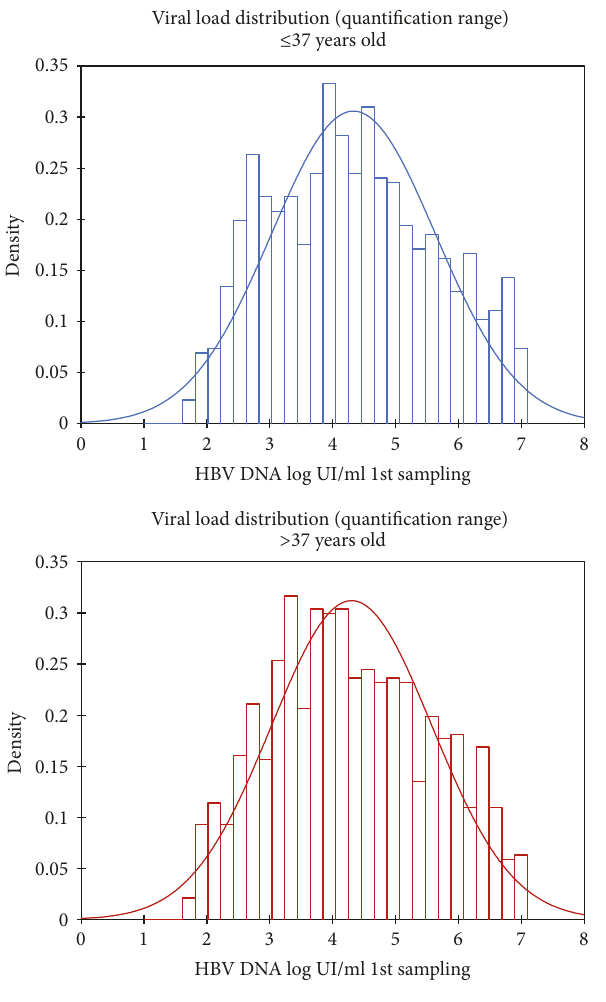
Figure 3: Distribution of the viral load at first sampling, according to age, in people from the “Detectable and Quantifiable” category.